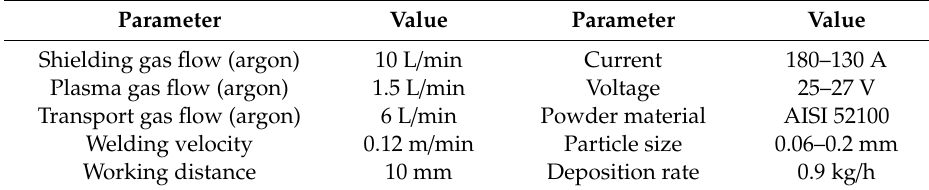
Figure 3. ( a ) Experimental setup of the welding process; ( b ) adjustment of current intensity. Table 2. Welding parameters.